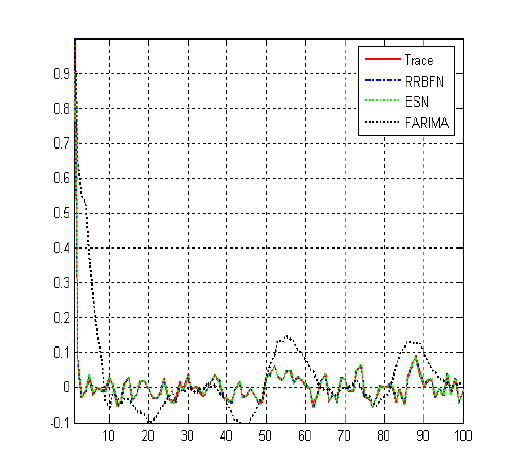
Fig. 11. 10-Step ACF Plot (10-Second